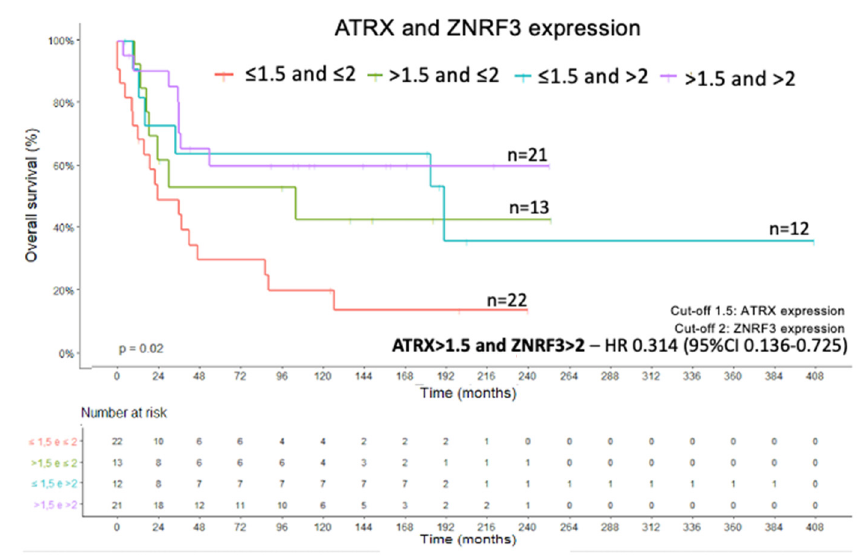
Figure 6. Overall survival curve of combined ATRX and ZNRF3 protein expressions levels.